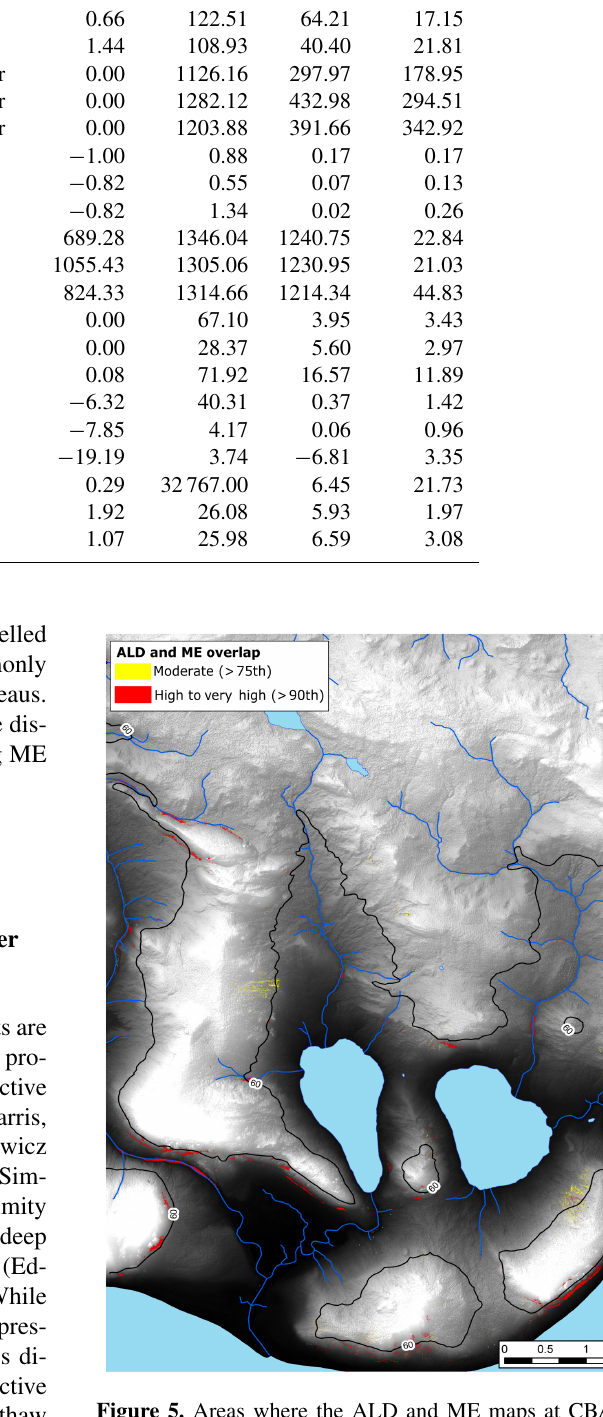
Figure 5. Areas where the ALD and ME maps at CBAWO have overlapping susceptibilities (superimposed over the 1m shaded re- lief DEM). The marine limit is denoted by the 60m contour